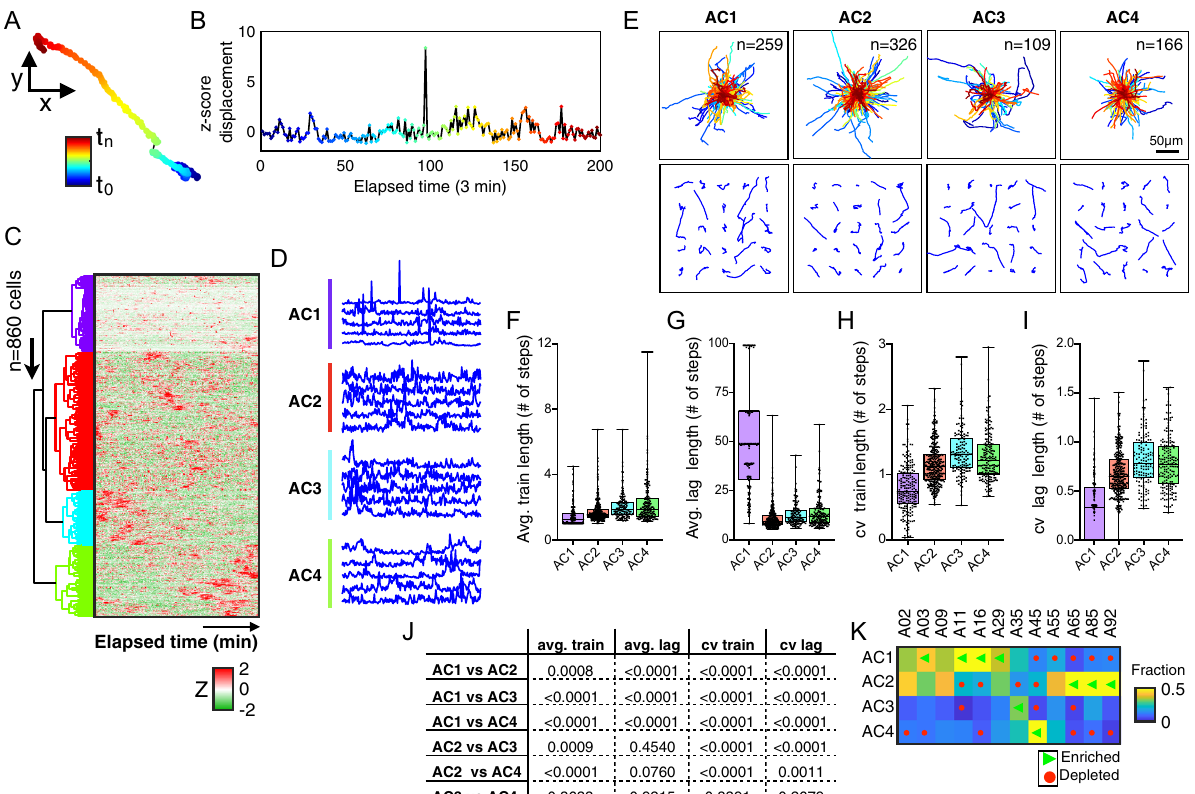
Fig. 3 Cellular activity describes age-associated motility patterns and heterogeneity. A Color-coded trajectory of a representative cell as a function of elapsed time (navy blue-to-maroon). B Plot showing the corresponding one-dimensional displacement for the same individual cell, here after referred as the activity pro fi le. C Heatmap showing the cellular activity pro fi les for all cells, across all ages ( n = 860 cells). Each row represents a single cell and each column from left to right represents elapsed time. Five colored dendrogram branches represent hierarchical clustering using the city block distances with ward linkages along the axes of maximum variation. D Line plots showing fi ve representative cellular activity pro fi les for single cells within each activity cluster. E Trajectories of cells within each activity cluster; top panel shows a grid of 25 randomly selected cell trajectories per cluster; bottom panel shows the origin-centered trajectories for all cells per cluster, with the number of cells within each cluster indicated in the upper left corner. F – I Box plots showing the extent of bursty dynamics per activity clusters; average train lengths ( F ), average lag lengths ( G ), CV of train lengths ( H ), CV of lag lengths ( I ). Error bars denote the maximum and minimum, with individual data points shown as black dots. J Table of p -values showing comparisons among the four activity clusters for average train length, average lag length, cv train length, and cv lag length. K Heatmap showing the abundance of cells within each activity cluster per age, green triangles denote signi fi cantly enriched and red circles denote signi fi cantly depleted ( p -value < 0.05). COMMUNICATIONS BIOLOGY| (2021) 4:81